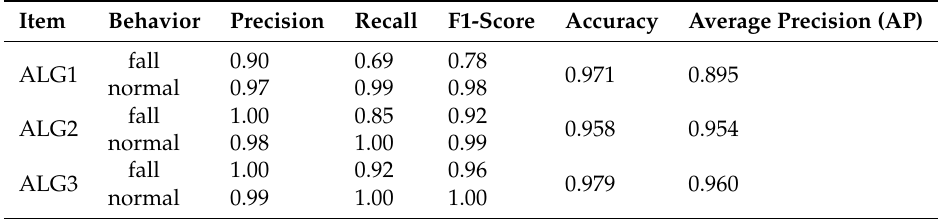
Table 4. The evaluation of classifiers for algorithms.